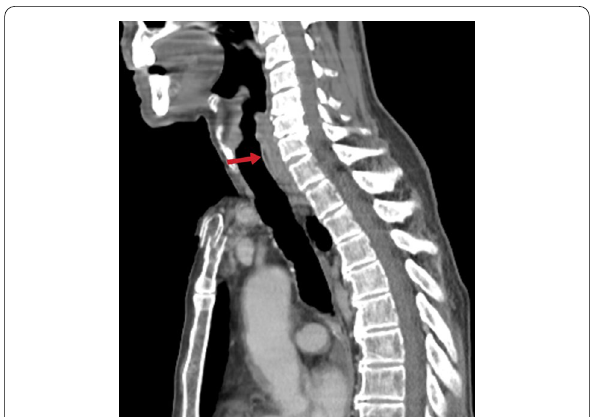
Fig. 8 A 68-year-old-male. Sagittal reformatted contrast-enhanced CT image reveals an increased thickness of the larynx’s posterior wall (arrow). Sternum fracture is also noted in the manubrium